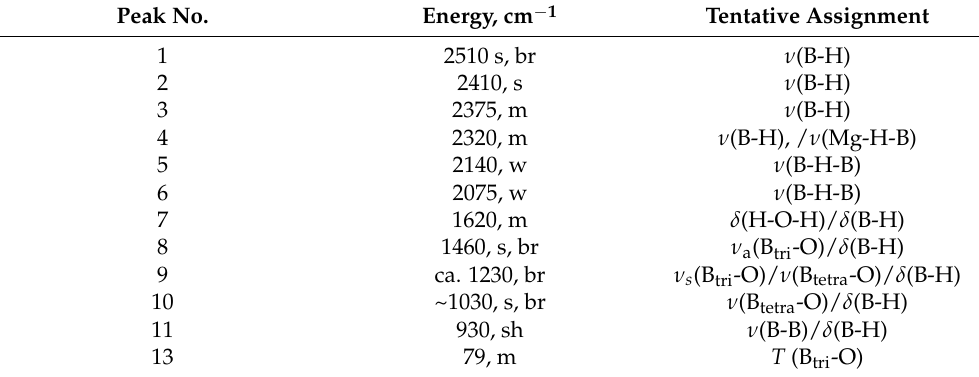
Table 4. Experimentally observed peaks in the FTIR spectra of γ -Mg(BH 4 ) 2 decomposed at 260 ◦ C and 280 ◦ C. All of the frequencies are in cm − 1 . Peak